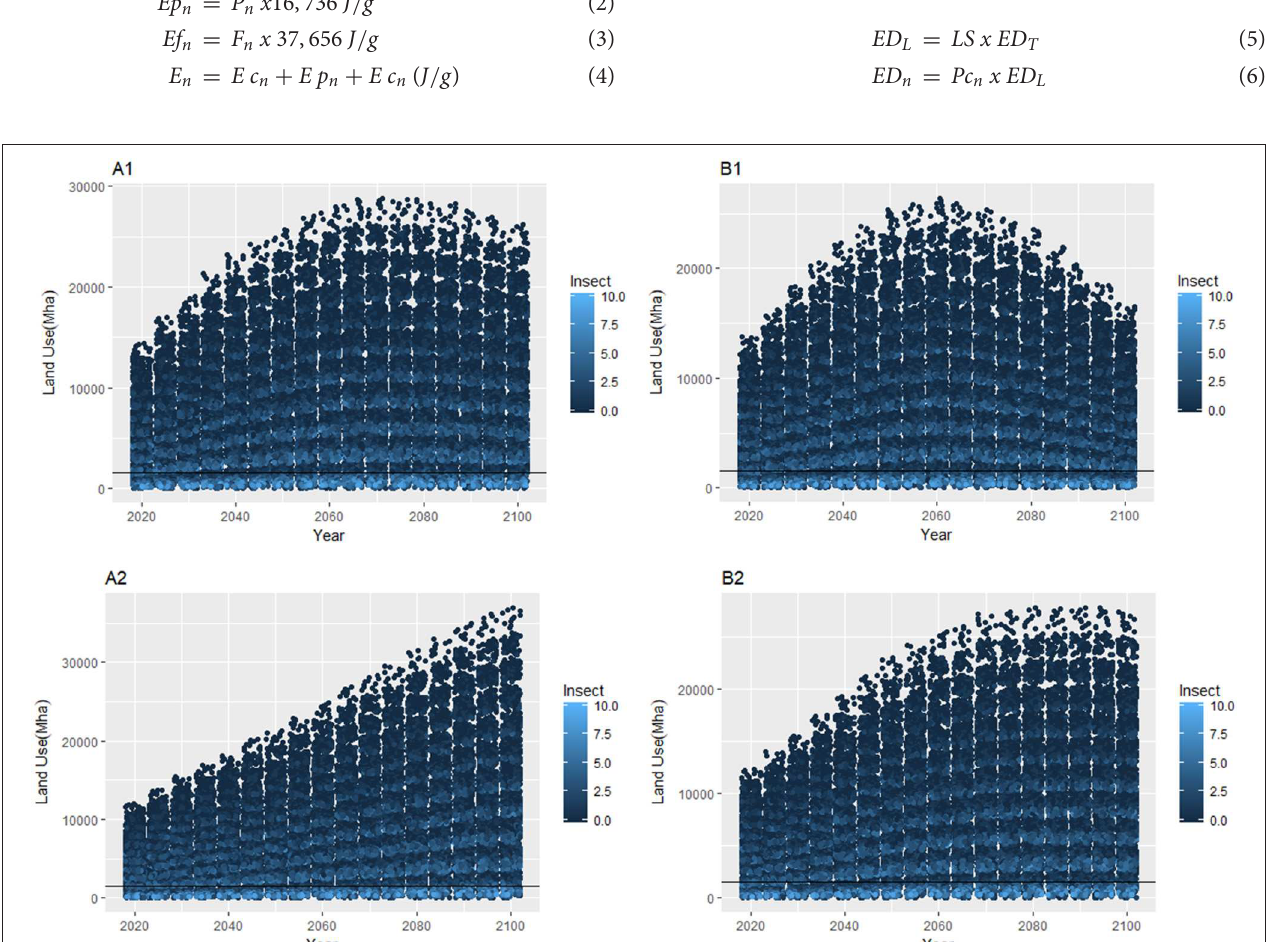
FIGURE 1 | Total land use for livestock needed to fulfill the calorie demands in SRES A1–B2 . Each dot represents a single policy code of livestock composition. The color of the dot represents the rate of insects to be used by that respective policy to meet the calorie demand (right-hand scale). The black horizontal line represents the current cropland, which is 1,550